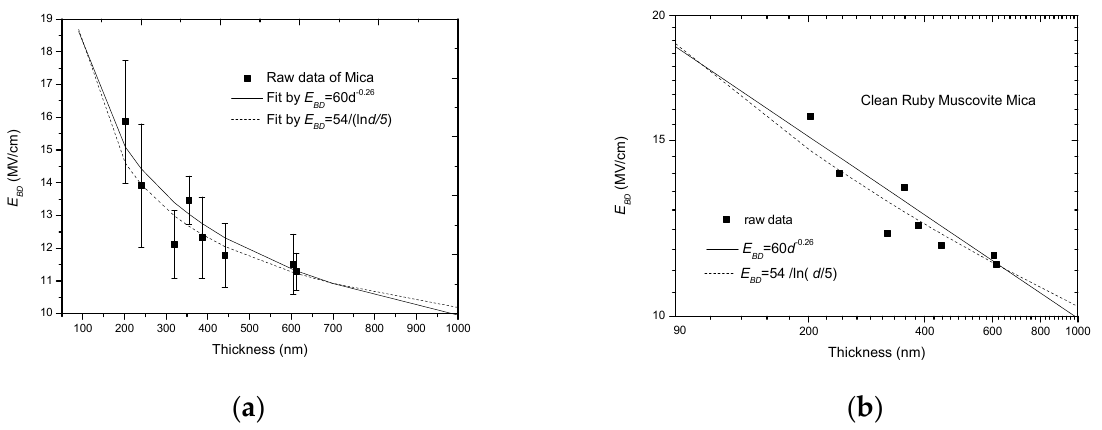
Figure 6. Comparison between the minus power relation and the reciprocal-single-logarithm relation with raw data from Austen [30]. ( a ) Two types of fitting in a linear coordinate system, ( b ) two types of fitting in a log-log coordinate system.